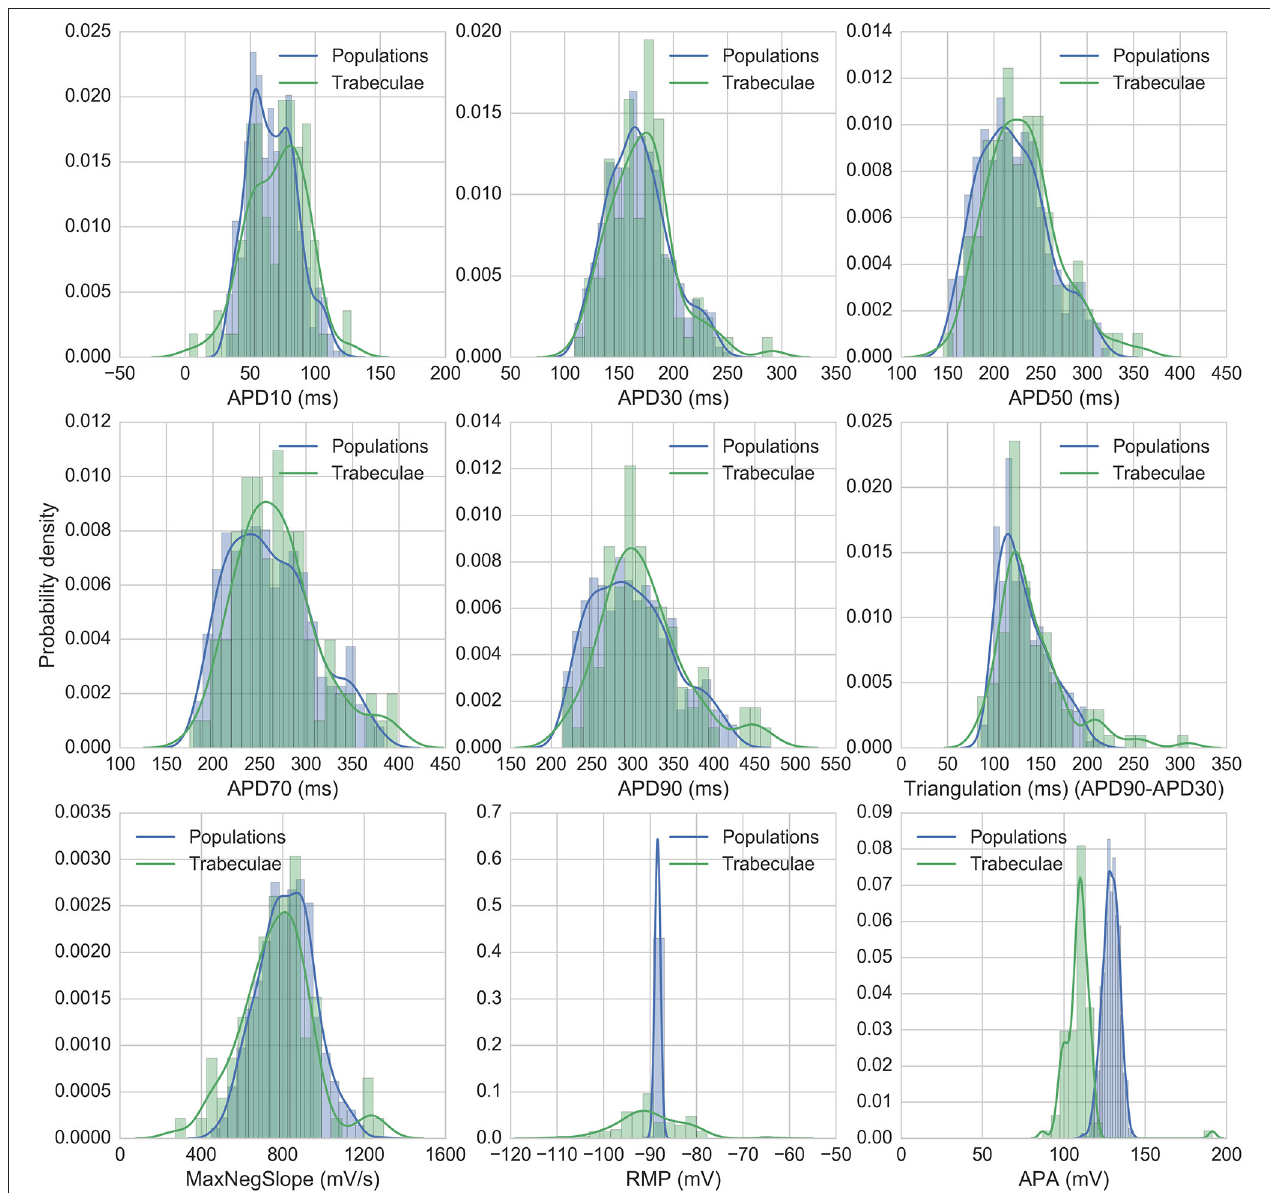
FIGURE 2 | Distributions of experimental and model biomarkers. Normalized histograms and probability density estimates for biomarkers from all trabeculae (green, n = 89) and from all populations of models (blue, n = 860) under control conditions 1 Hz pacing.